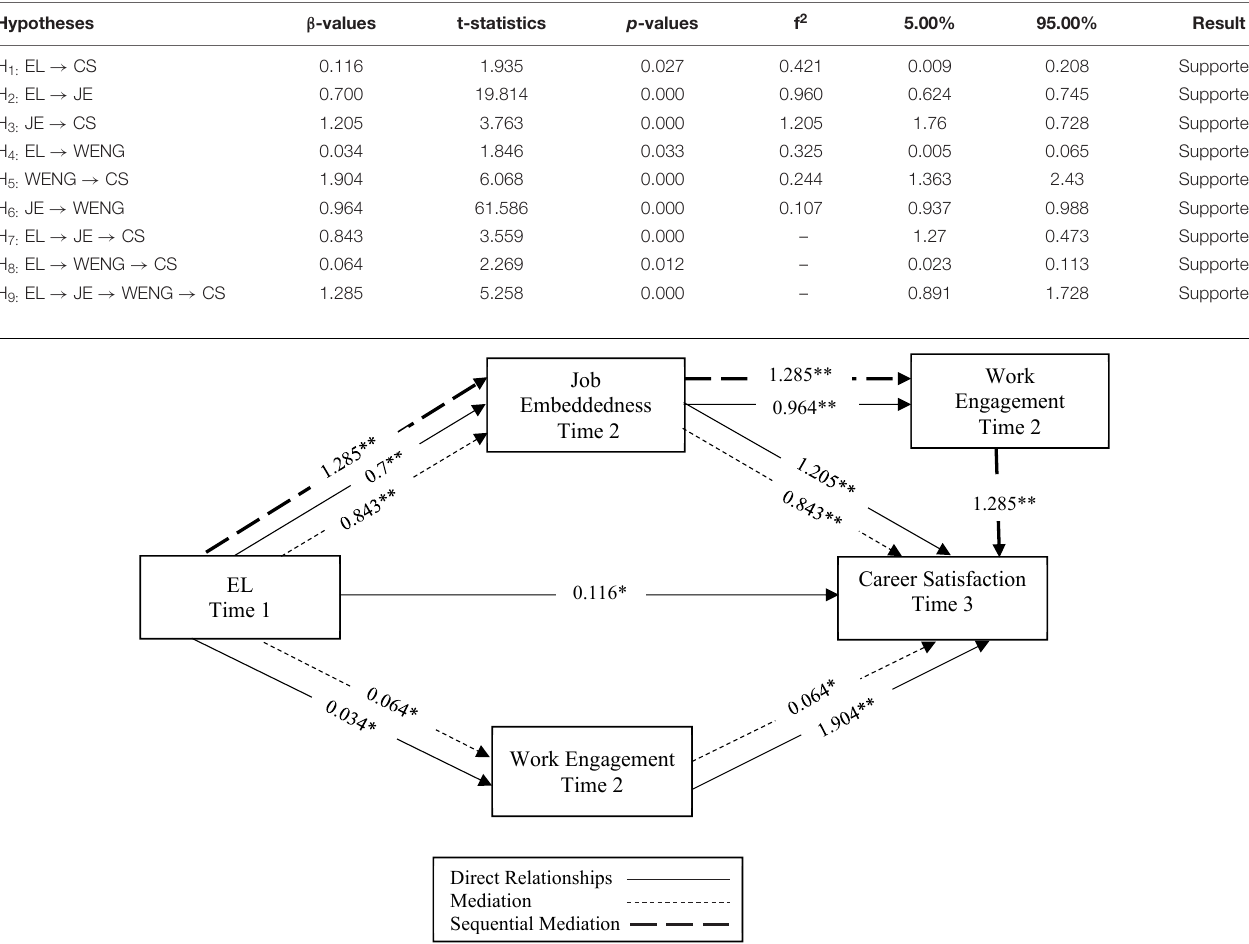
TABLE 4 | Summary of the results of the structured model: direct and indirect effects.